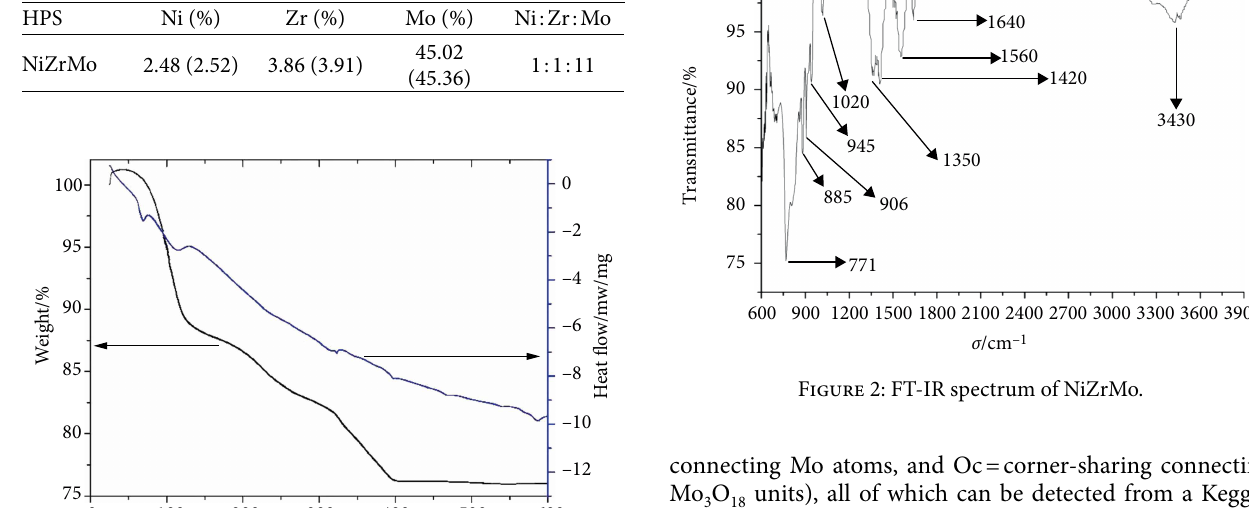
Table 1: Elemental analysis of the heteropoly acid salt.